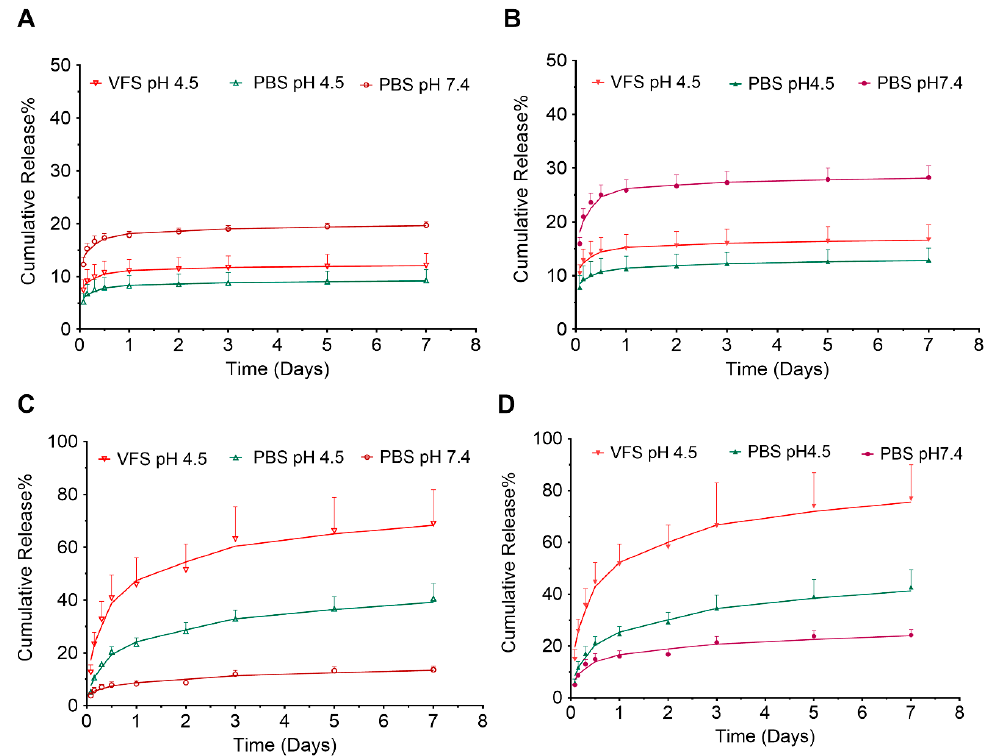
Figure 3. In vitro release of ARVs from PLGA nanoparticles in VFS at pH 4.5, and buffers at pH 4.5 and pH 7.4. ( A ) GRFT release from NP-GRFT and ( B ) NP-DPV/GRFT. ( C ) DPV release from NP-DPV and (D) NP-DPV/GRFT. NP-nanoparticles.